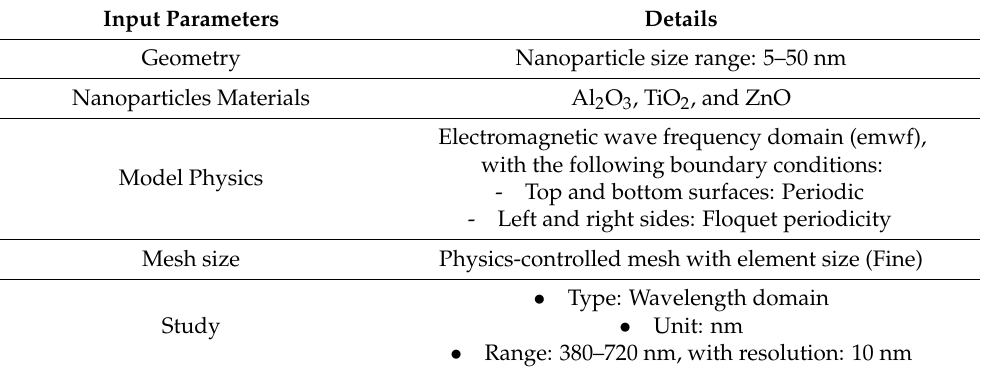
Table 3. Input parameters to the COMSOL Multiphysics model.